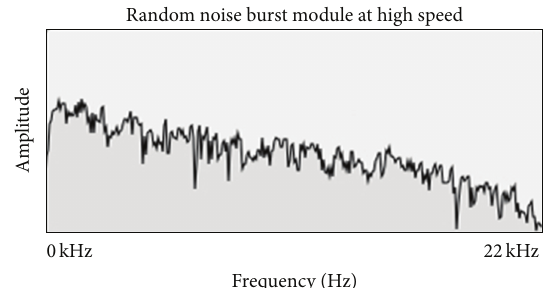
Figure13:Spectrogramshowingasnapshotoftherumblingmodule at high speed.